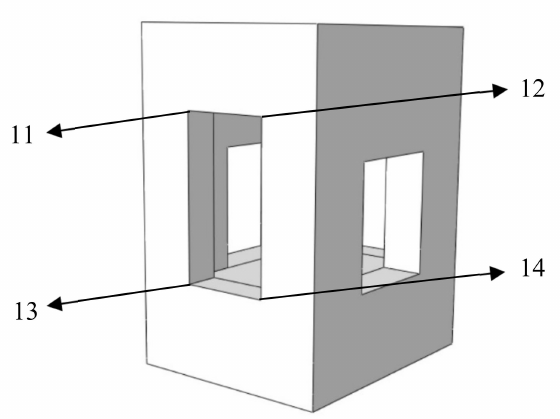
Figure 15. Positions of strain test.